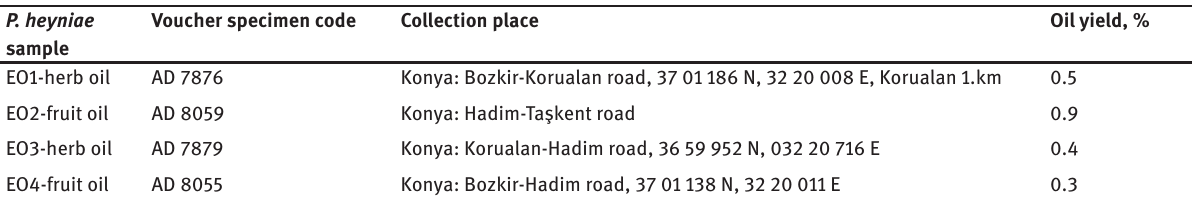
Table 3: Prangos heyniae samples collection data and the oil